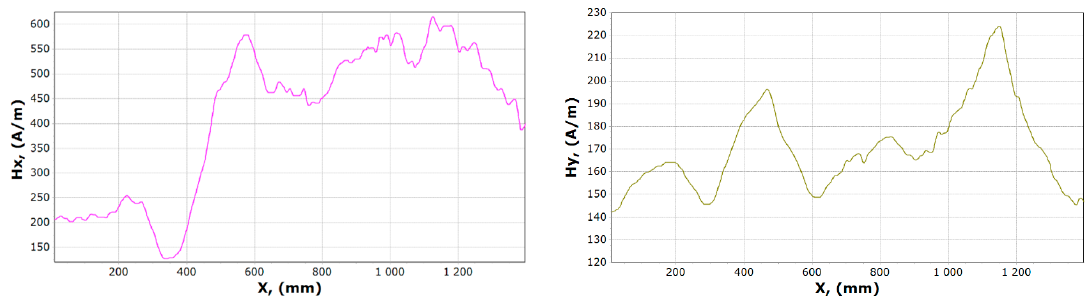
Figure 11. Graphs of tangential Hx and normal Hy component of the magnetic field, for sample 16.